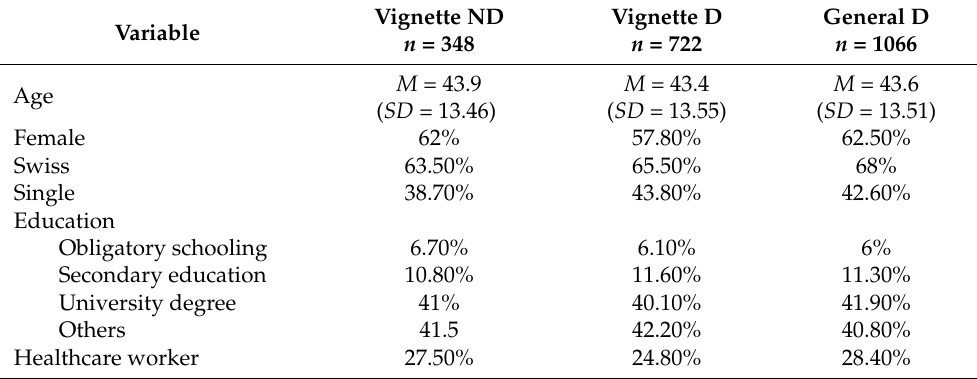
Table 2. The characteristics of the sample for Vignette ND, Vignette D, General D.